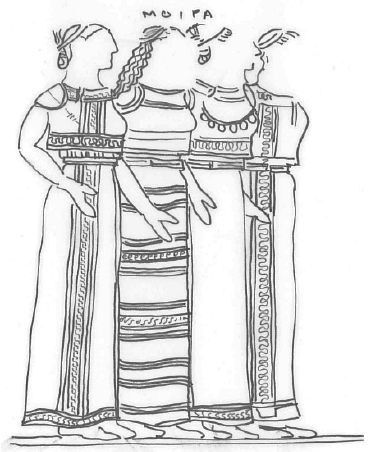
Figure 4. Black-figured volute crater (Attic). Florence, Museo Archeologico inv. 4209. Signed by Kleitias (painter) and Ergotimos (Potter), ca. 570 BCE. ( left ) The Muses; ( center ) Hestia, Demeter, Chariklo; ( right ) the Horai. Drawing by the author.